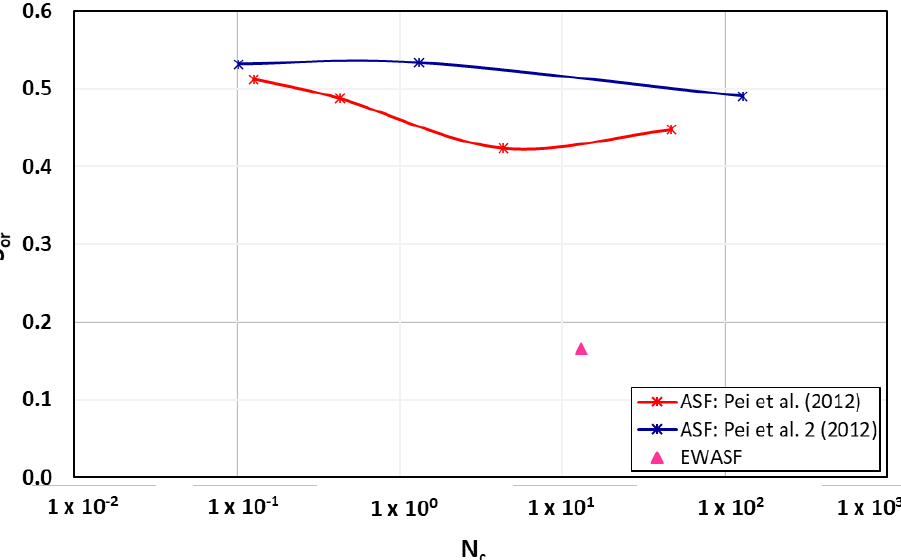
Figure 3. Comparison of capillary desaturation tendency of hybrid EWASF with conventional ASF.